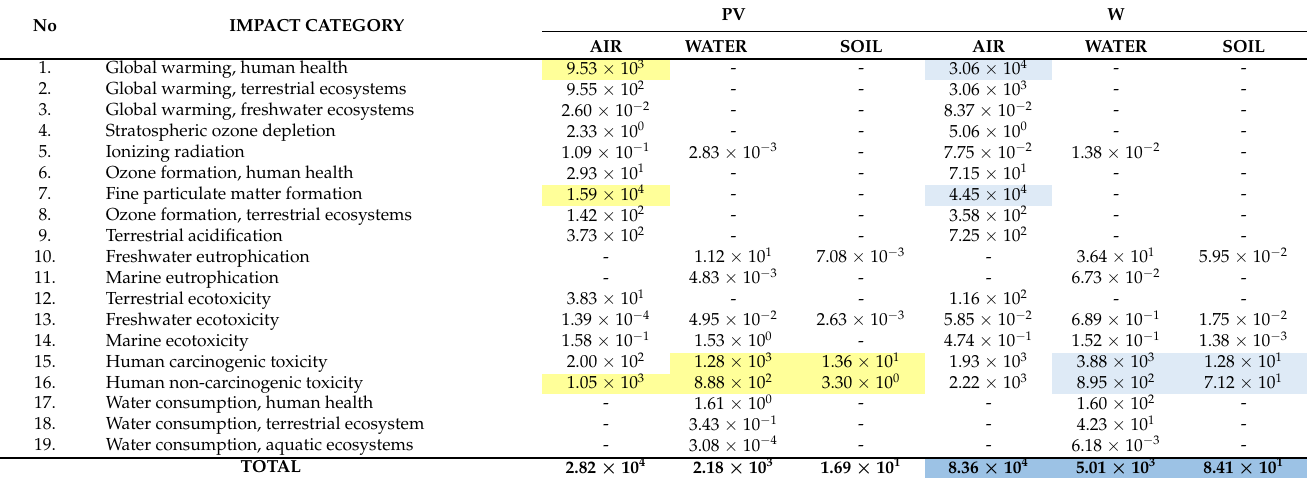
Table 8. Grouping and weighting results of environmental consequences for human health, with consideration of compartments, present in the life cycle of wind (W) and photovoltaic (PV) power plants (unit: